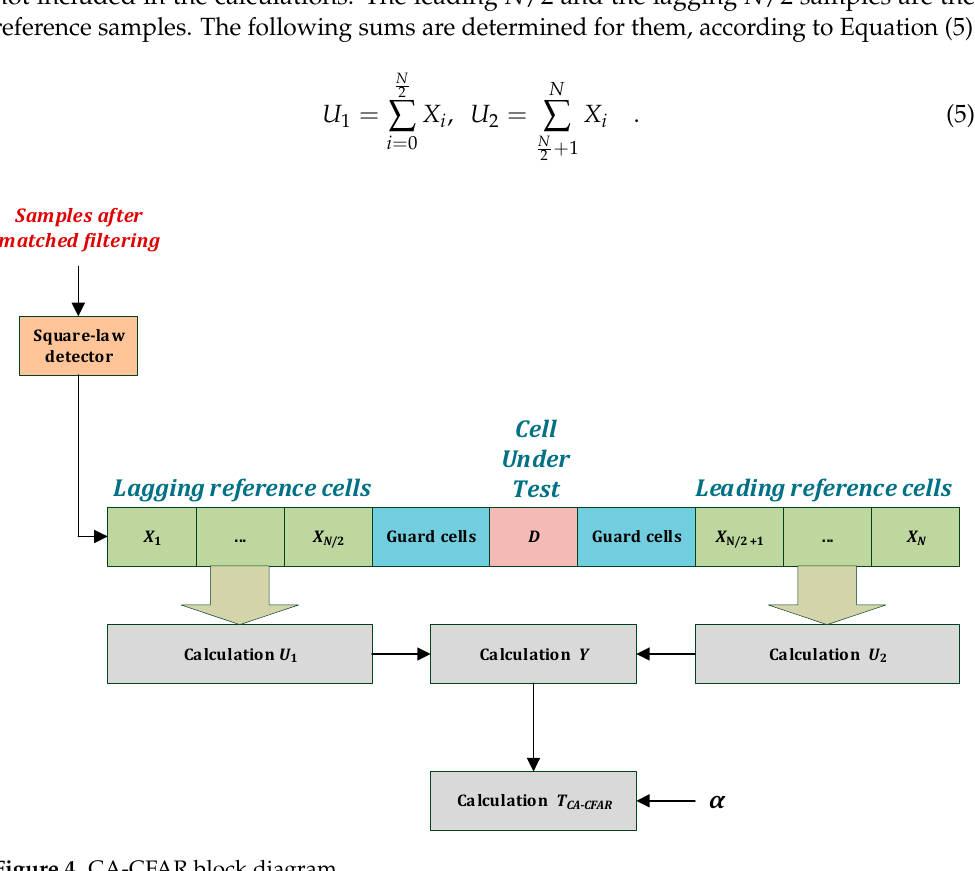
Figure 4. CA-CFAR block diagram.